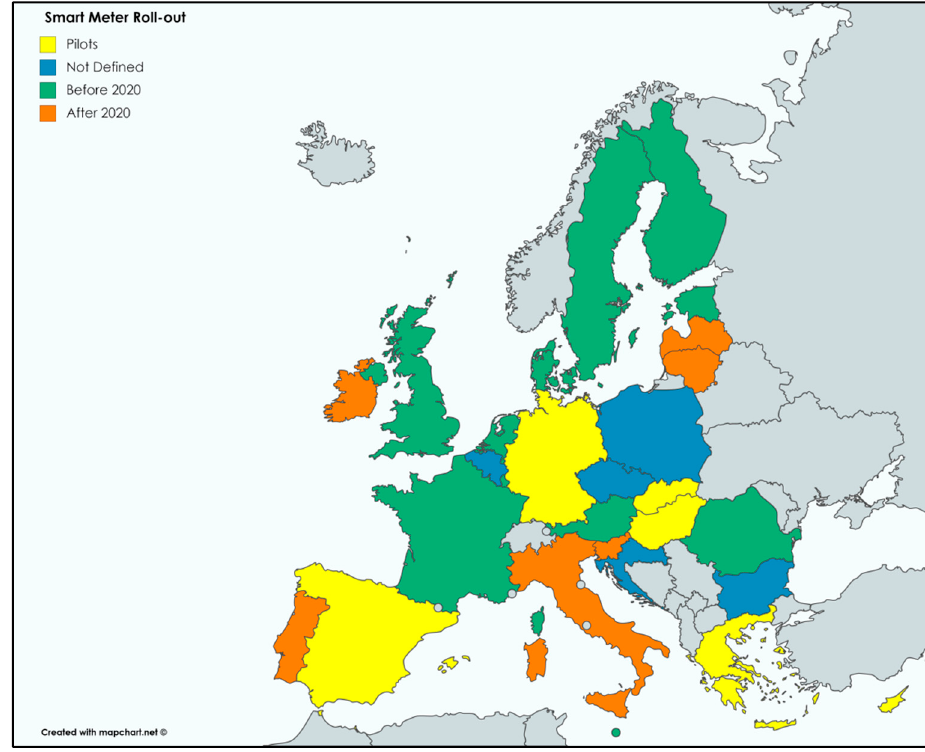
Figure 1. Status of smart meter roll-out in the EU-28 (JRC, 2019).